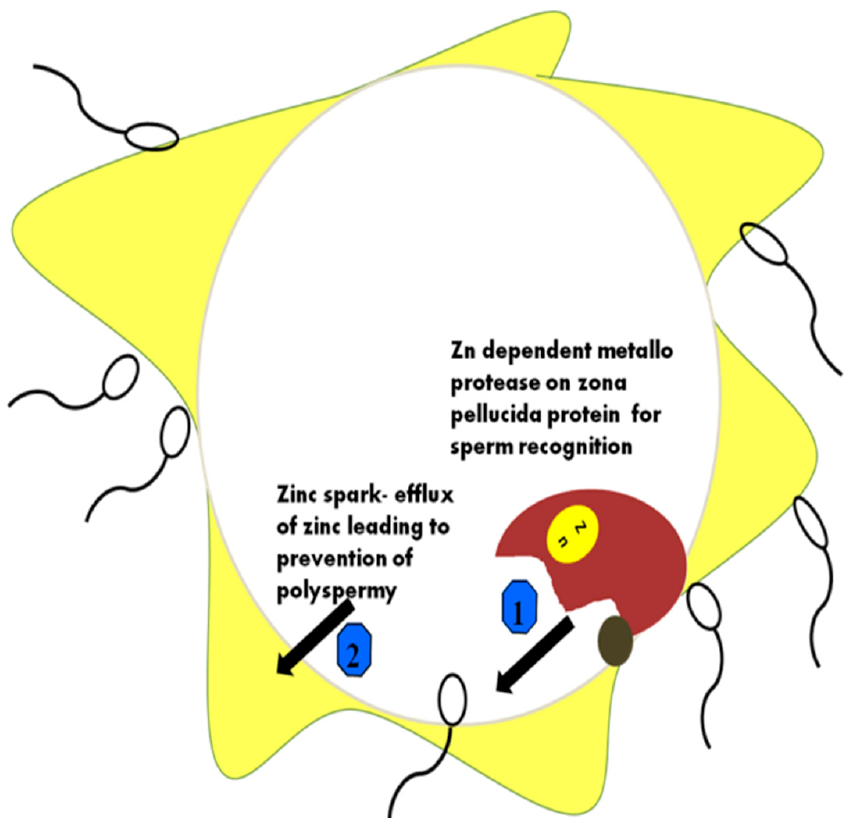
Figure 2. Different roles of Zn ions during sperm–ova interactions. Zona pellucida (ZP) hardening occurs through membrane protein changes when the ZP protein acts using the Zn-binding protease. The major functions of zinc in the prevention of polyspermy are depicted in the figure. 1—Zn dependent metalloprotease on zona pellucida for sperm recognition; 2—how Zn efflux results in